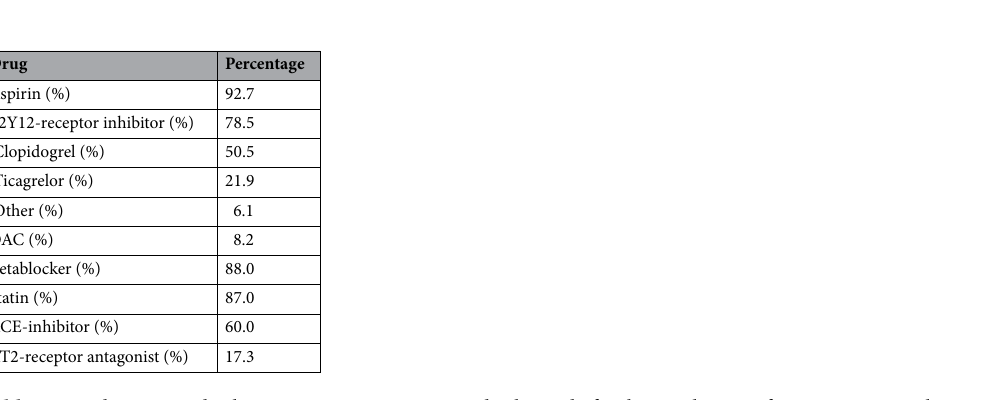
Table 3. Medication at discharge among 1379 patients discharged after hospitalization for ACS. OAC oral anticoagulation, AT2 angiotensin